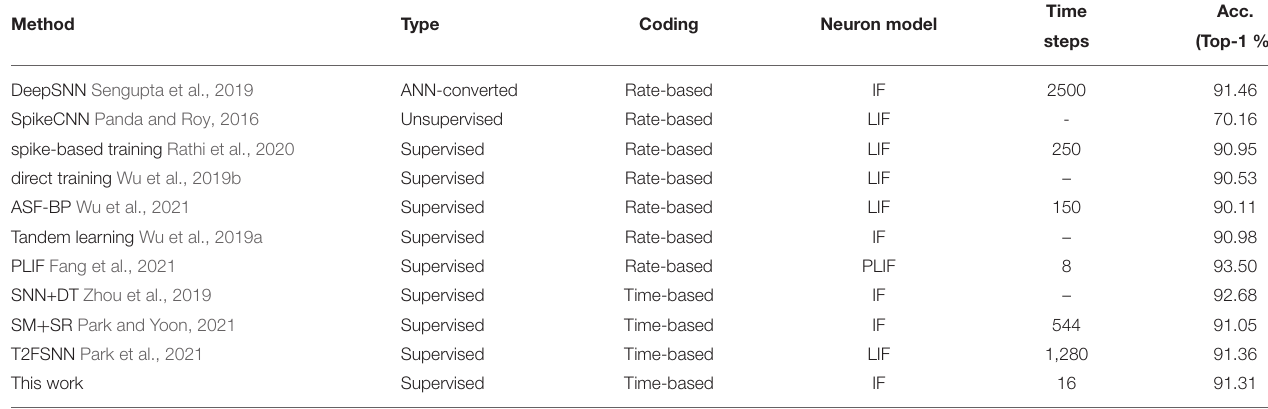
TABLE 3 | Test accuracy of different SNNs models on